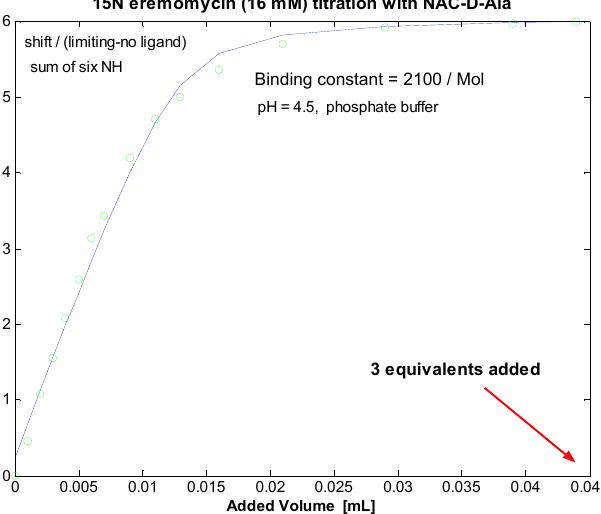
Figure 6. Overlayed NMR diffusion (DOSY) experiments of eremomycin: red is in the absence of ligand; blue is after coaddition of 1.6 equivalent N -Ac- D -Ala- D -Ala. On the log10-based vertical scale, a 0.1 unit difference indicates a factor of two for the molecular mass.